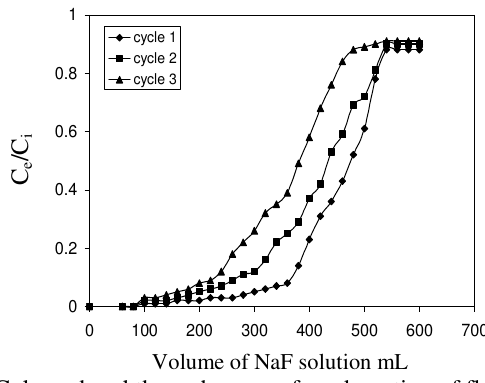
Figure 11. Column breakthrough curves for adsorption of fluoride on CCS.